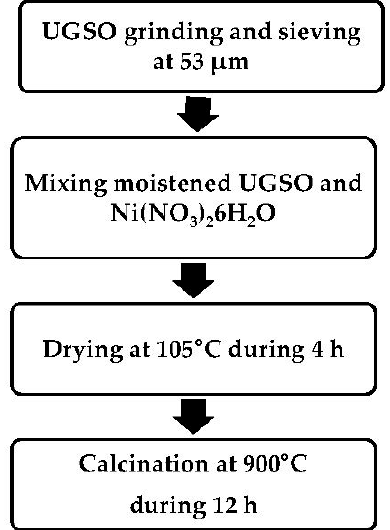
Figure 16. Ni-UGSO synthesis by the improved solid-state reaction.